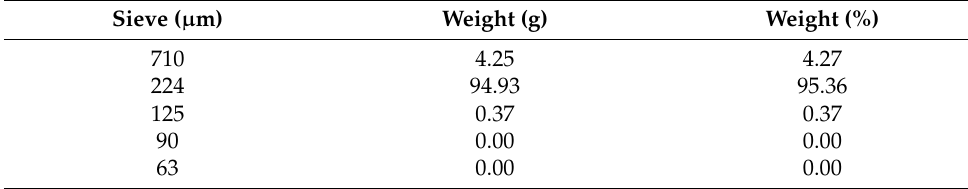
Table 1. R.m. particle size distribution.